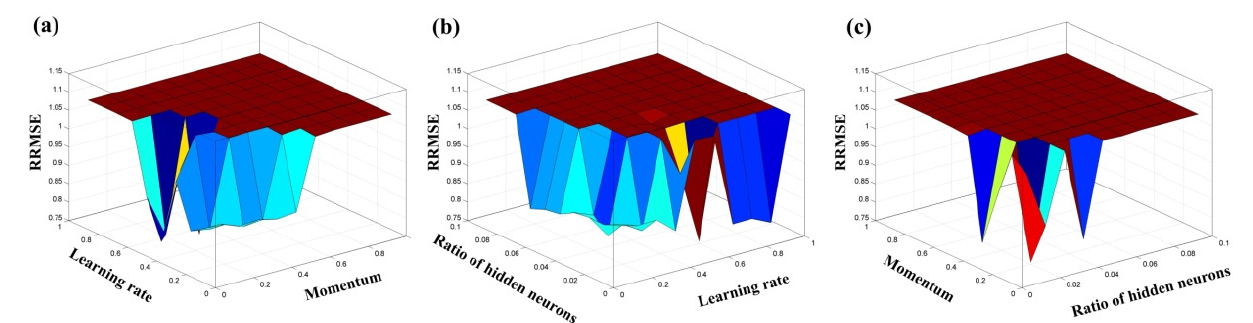
Figure 5. Three-dimensional plots of relative root mean squared error (RRMSE) variations at ( a ) a fixed hidden neurons ratio of 0.02, ( b ) a fixed momentum of 0.2; and ( c ) a fixed learning rate of